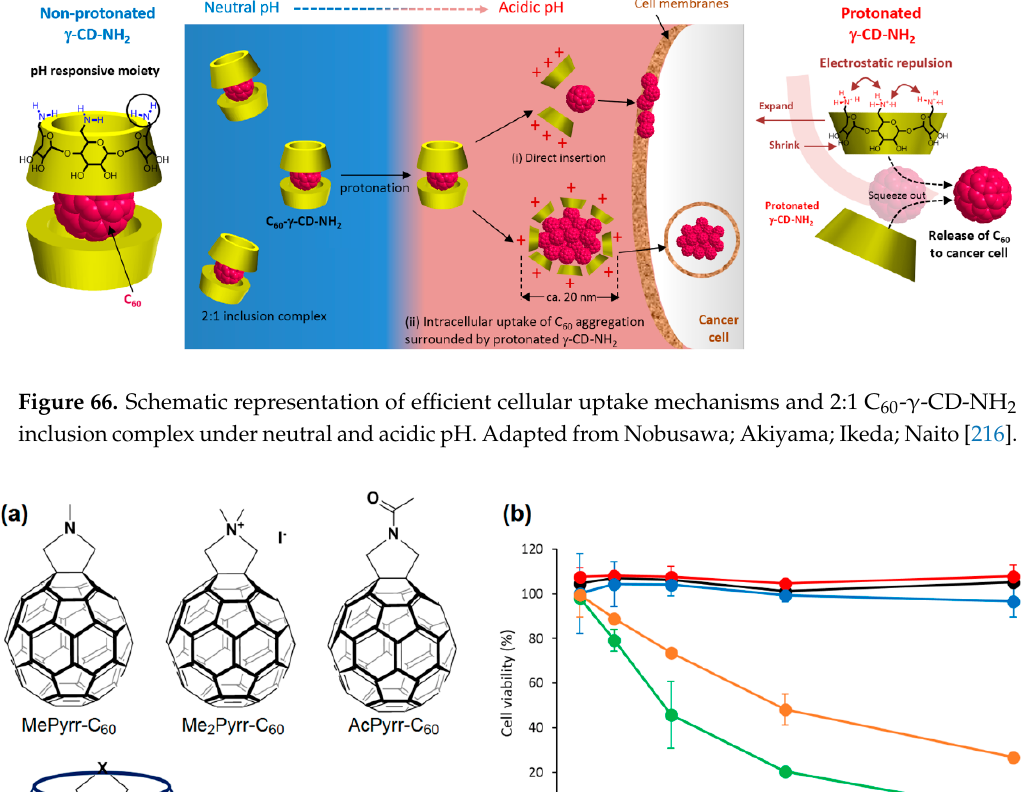
Figure 65. Cell viability of HeLa cells treated with C 60 - γ -CD-NH 2 after irradiation ( λ = 400–500 nm for 30 min). * p < 0.005 as compared to the PDT activity at pH 7.4. Adapted from Nobusawa; Akiyama; Ikeda; Naito [216]. Molecules 2018 , 23 , x FOR PEER REVIEW